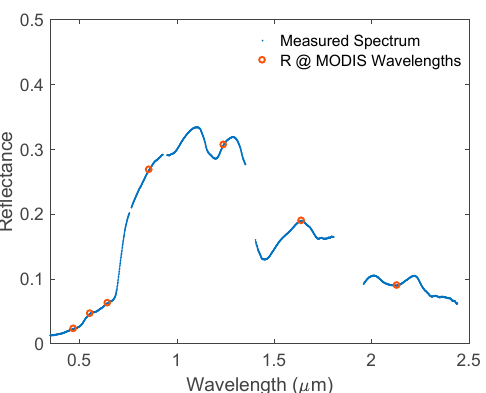
Figure 8. A randomly chosen experimental reflective spectrum from USGS database (blue). The red circle indicates the reflectances at the MODIS available wavelengths.